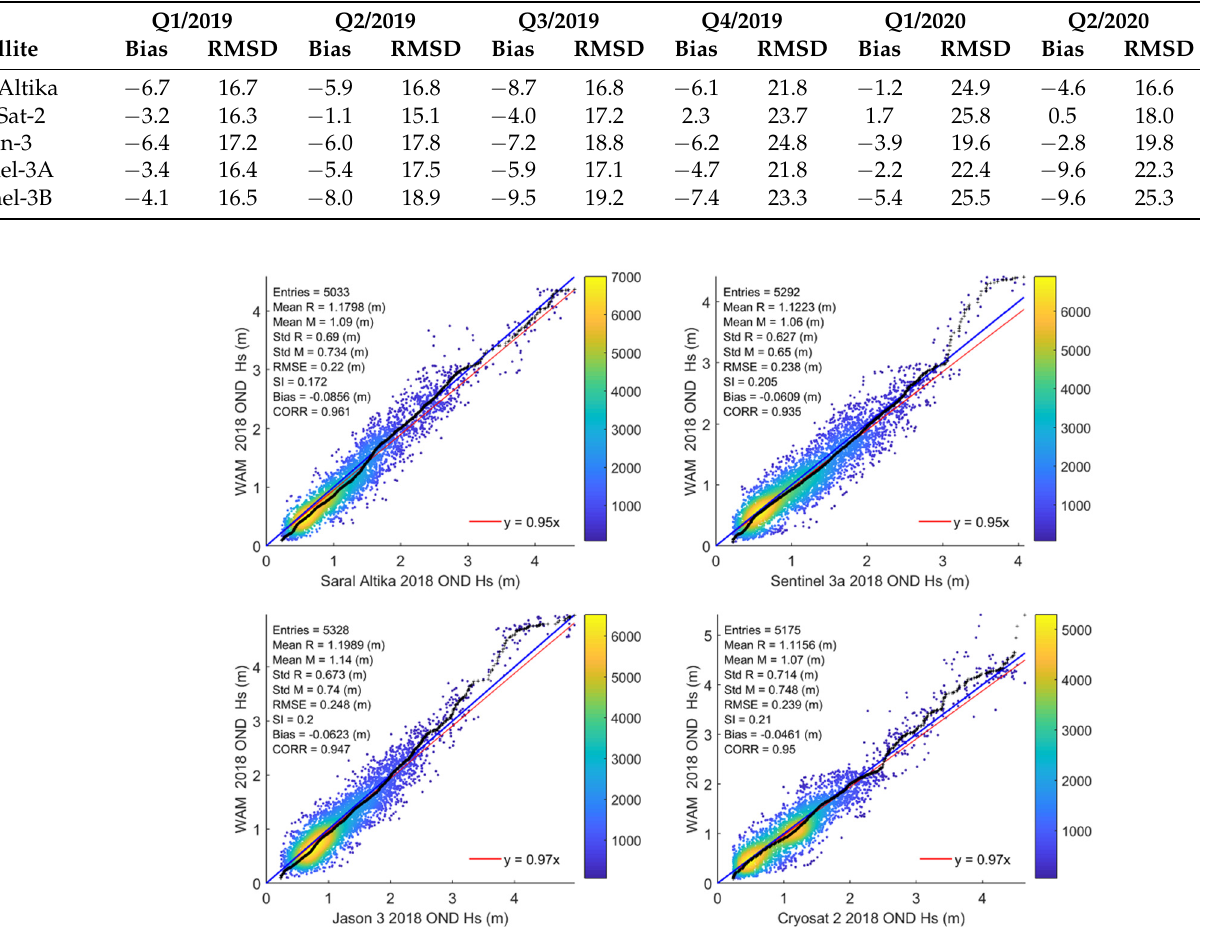
Figure 14. Scatter plots as in Figure 10, but for Q4 2018 and four different satellites.